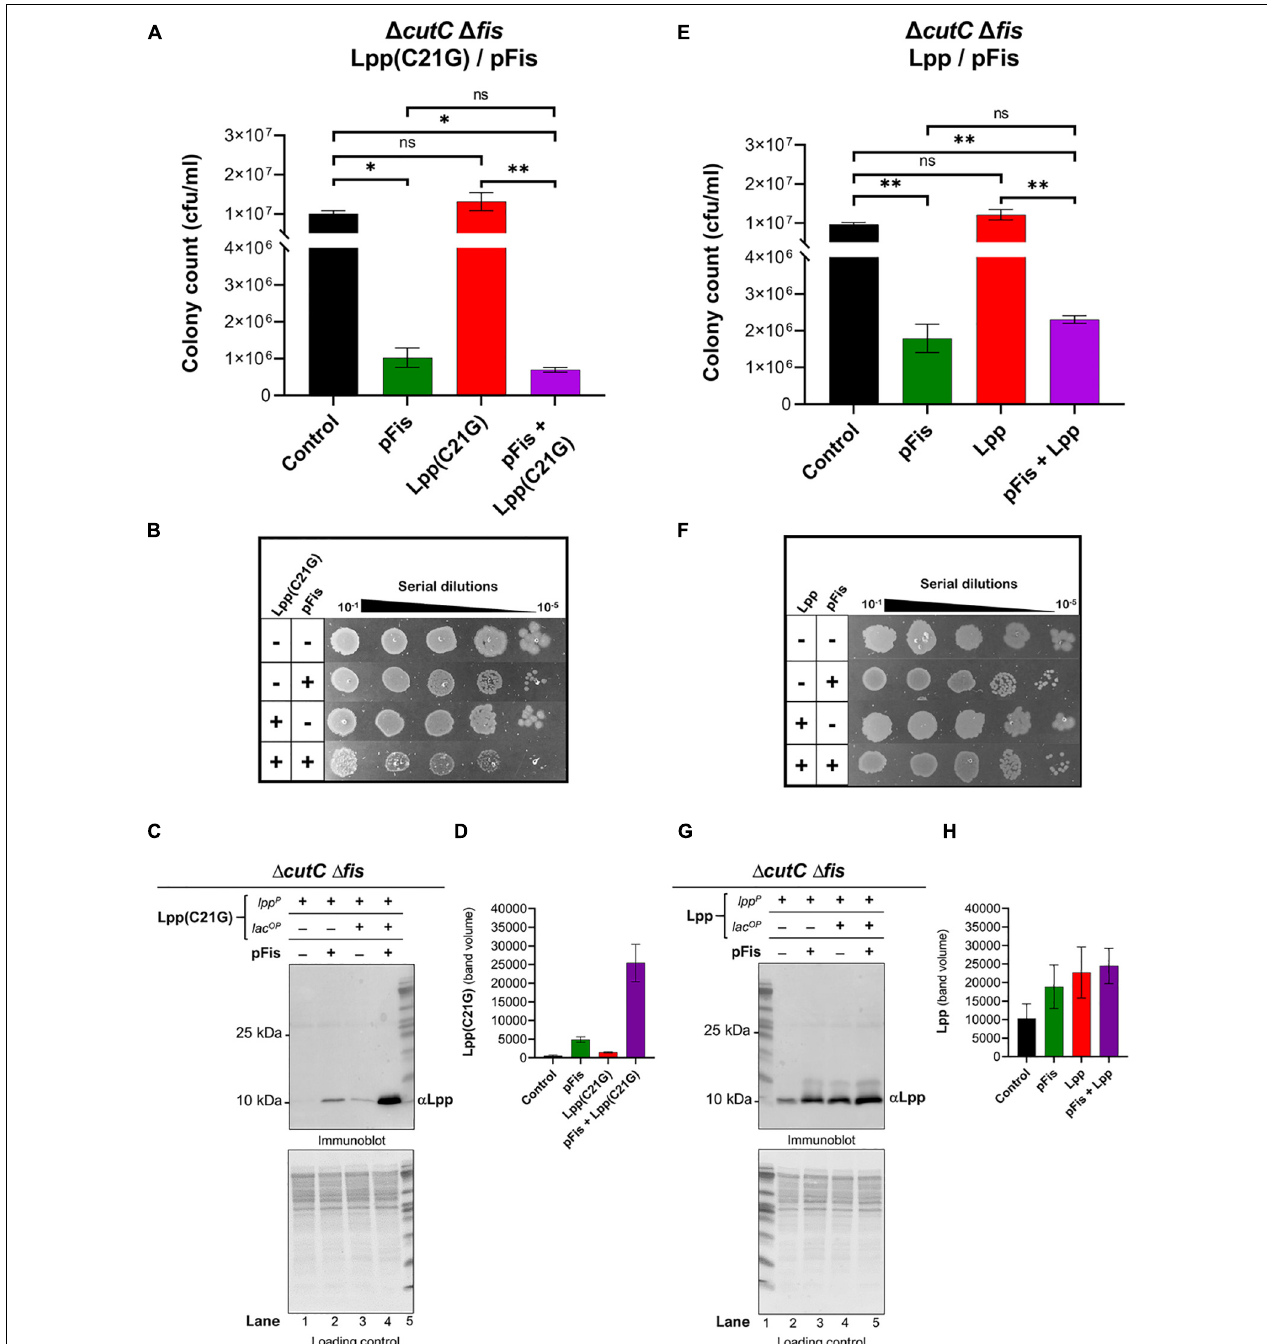
FIGURE 6 | fis-null cells lacking promoter for MicL-S small RNA can grow by expressing only low levels Lpp(C21G). (A) Viability of cutC-null fis-null cells expressing Fis (pFis) and Lpp(C21G). No inducer control (black); in the presence of 0.2% Arabinose (green) for Fis, 50 µ M IPTG (red) for Lpp(C21G), and 50 µ M IPTG + 0.2% Arabinose (purple) for both Lpp(C21G) and Fis expression in M9+CAA+Glu media. (B) Serial dilutions of cutC-null fis-null cells, capable of expressing plasmid-derived Lpp(C21G) and Fis, on agar plates. (C,D) Immunoblotting for the detection of Lpp(C21G) and quantitative analysis of Lpp(C21G) levels. (E) Viability of cutC-null fis-null cells expressing Fis (pFis) and Lpp. No inducer control (black), in the presence of 0.2% Arabinose (green) for Fis, 50 µ M IPTG (red) for Lpp, and 50 µ M IPTG + 0.2% Arabinose (purple) for both Lpp and Fis expression in M9+CAA+Glu media. (F) Serial dilutions of cutC-null fis-null cells, capable of expressing plasmid-derived Lpp and Fis, on agar plates. (G,H) Immunoblotting for the detection of Lpp and quantitative analysis of Lpp levels. Lpp(C21G) and Lpp are expressed via Lpp ( lpp P ) and Lac ( lacUV5 OP ) promoters. All loading controls are ponceau-S staining for total protein normalization presented in grayscale. Viability is expressed in cfu/ml and presented on a linear scale. Data are means ± SEM of at least three independent experiments. ∗ p < 0.05, ∗∗ p < 0.01, ns p > 0.05 in one-way ANOVA with Dunnett’s multiple comparison test.